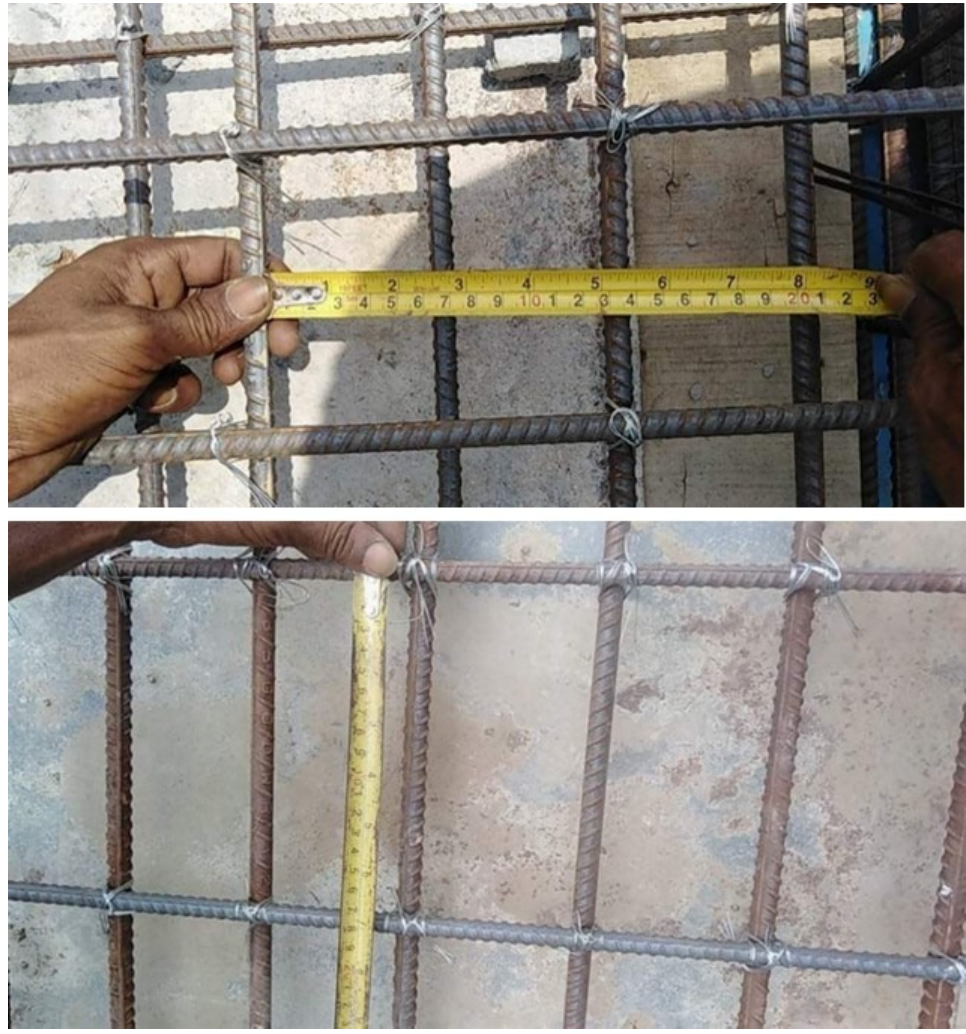
Figure 6. Rebar spacing in the case of elevated concrete slab (used with permission from Khadem [23]).